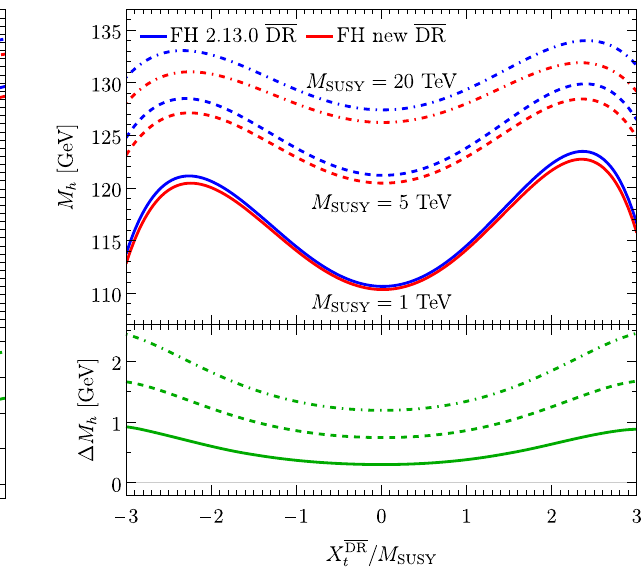
Fig. 2 Comparison of the M h predictions of FeynHiggs2.13.0 DR with FeynHiggsnew DR, where in the new version terms aris- ing from the determination of the propagator pole are omitted that go beyond the level of the corrections implemented in the irreducible self- energies. Left: Prediction for M h as function of M SUSY for vanish-